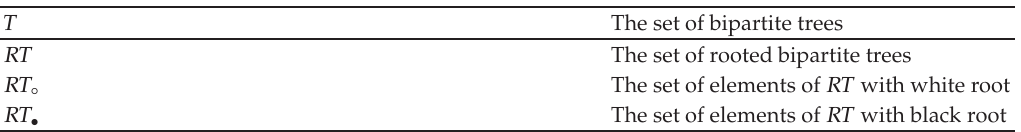
The set of elements of RT with black